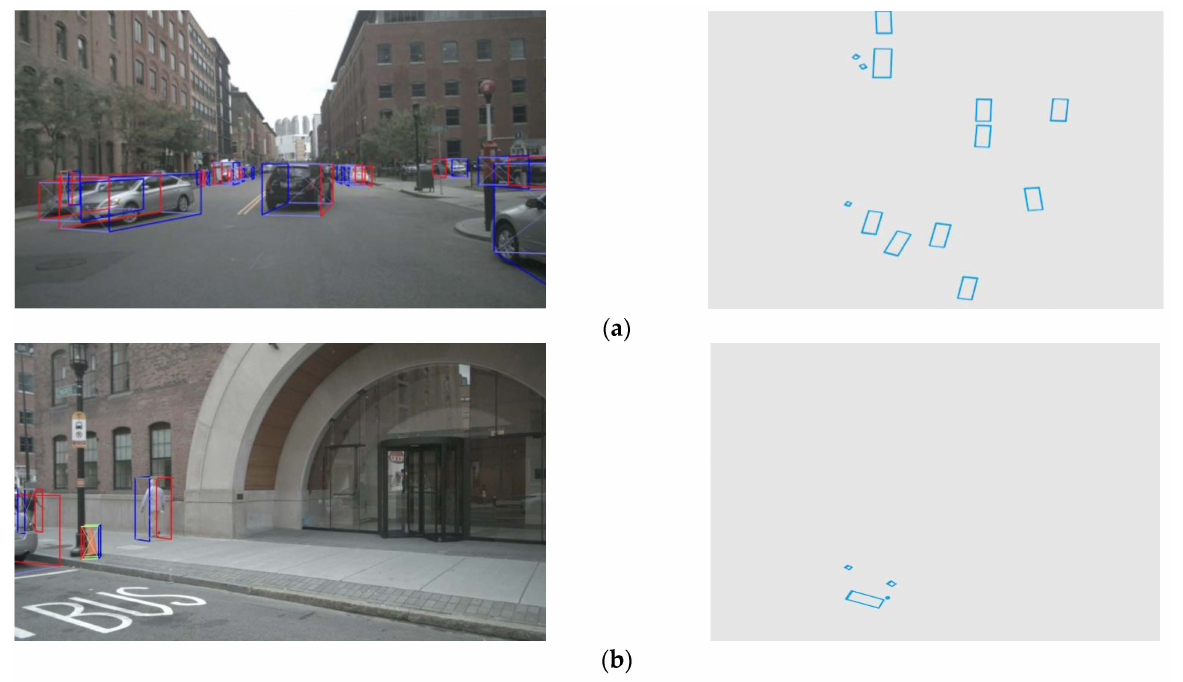
Figure 13. Detection results of targets in the near field area: ( a ) multi objective situation; ( b ) small target situation.